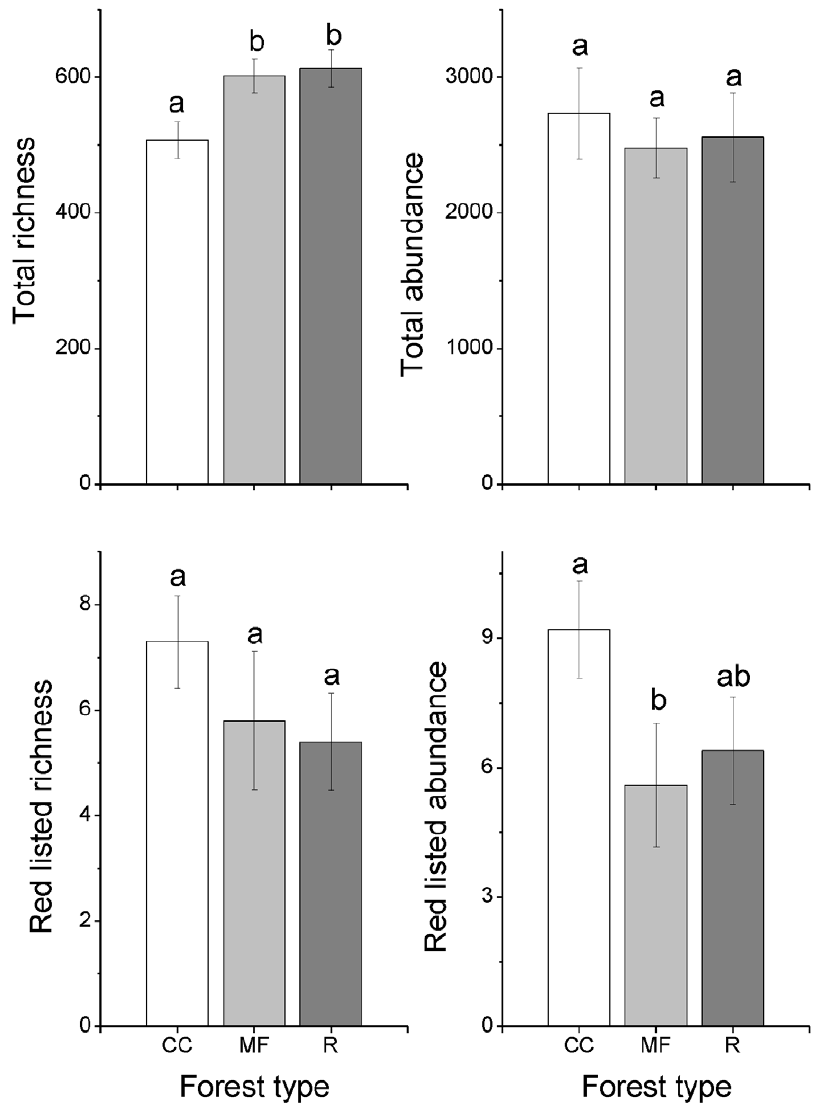
Figure 2. Abundance and species richness in the three different forest types. Abbreviations: CC=Clear-cuts, MF=Mature managed forests, R=Reserves. Bars with different letters denote statistically significant effects (Tukey test, p , 0.05). Vertical bars show 6 1 SE.